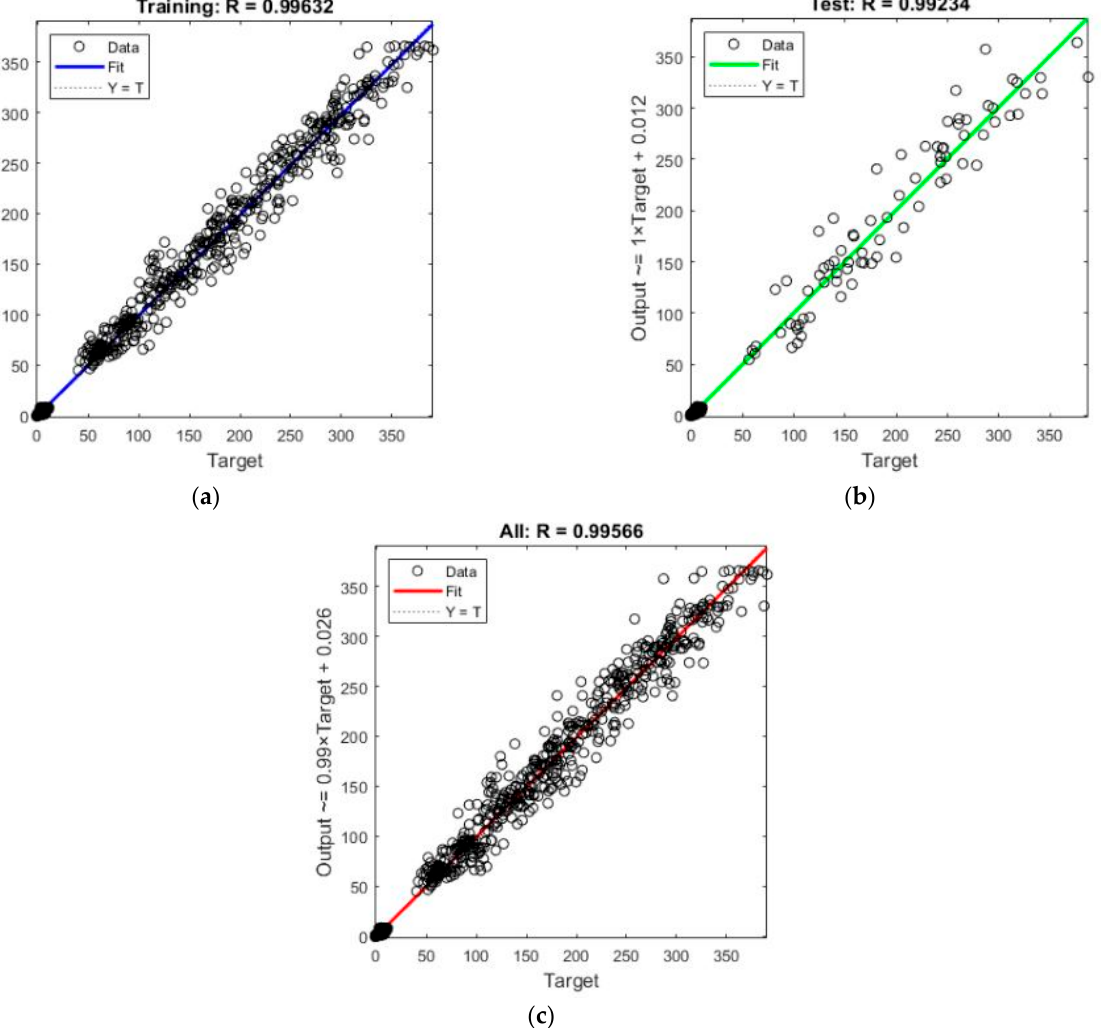
Figure 15. Regression obtained: ( a ) training phase, ( b ) test phase and ( c ) all system.